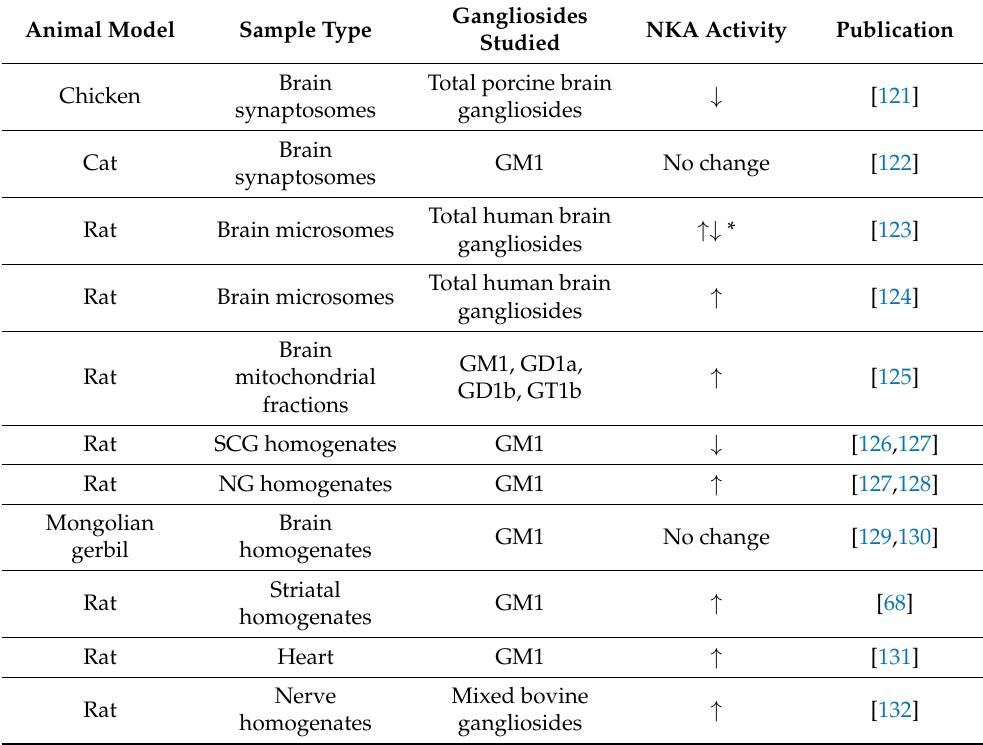
Table 1. Summarized data describing the effect of exogenously added gangliosides on NKA activity. Animal